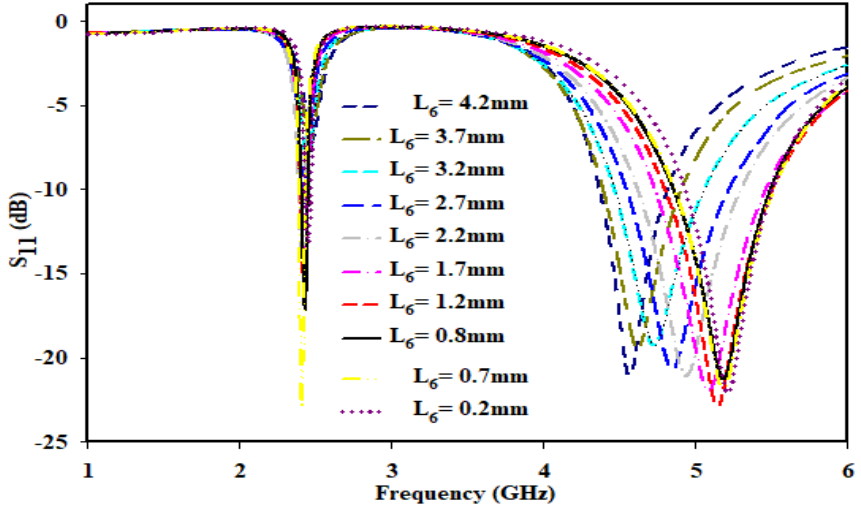
Figure 11. Variation in resonant frequency with respect to position of CDNG-MTM.